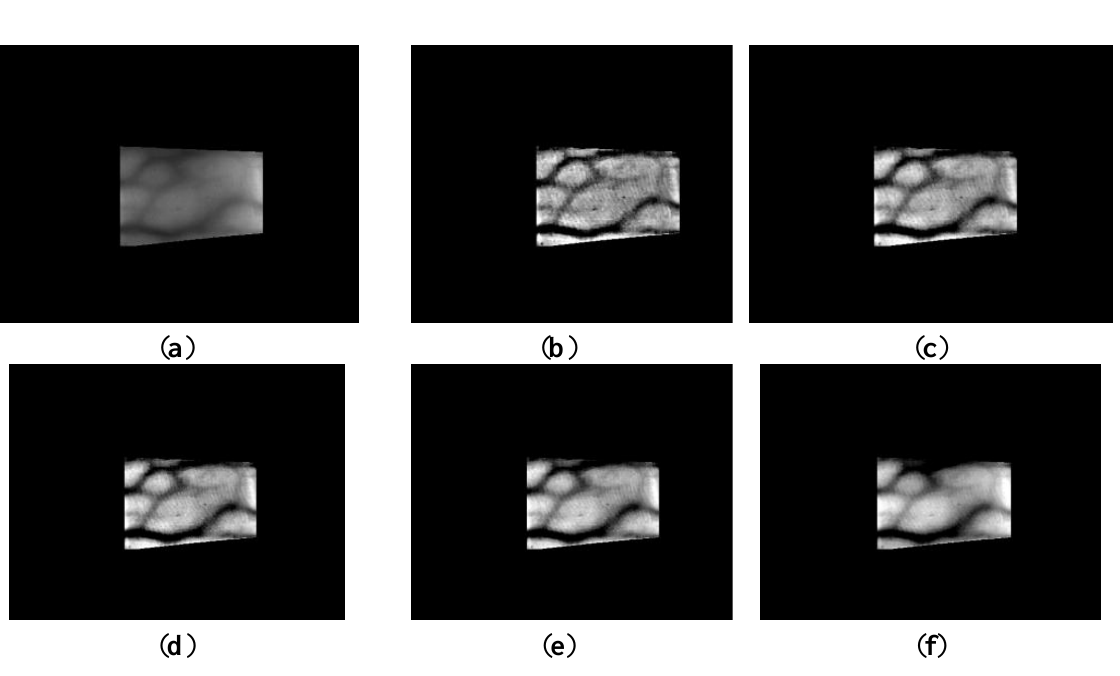
Figure 7. Retinex images obtained using various sigma values with images from database I: ( a ) the original image with the detected finger boundaries; Retinex images obtained using